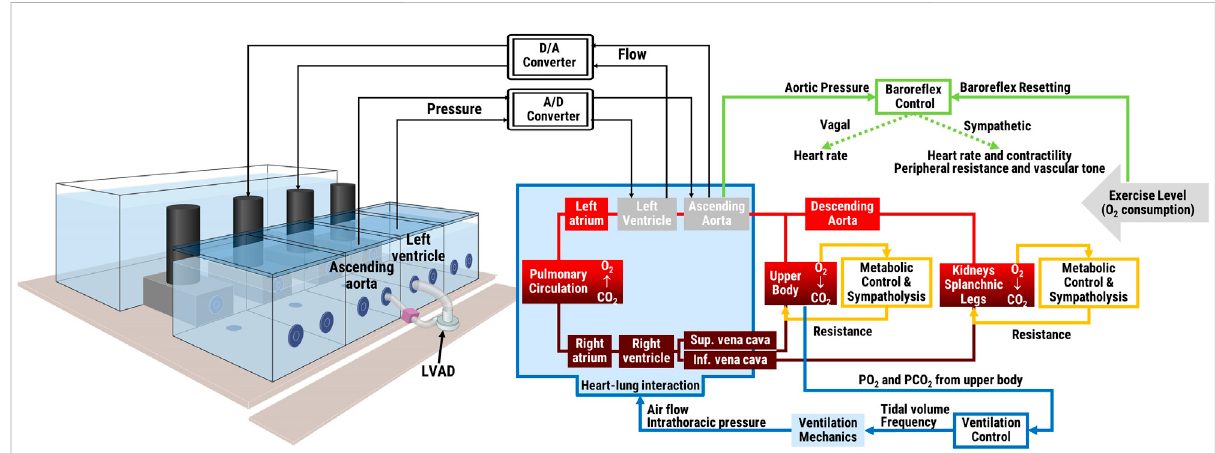
FIGURE 1 Schematic of the hybrid simulator: in vitro interface with an LVAD connected between two hydraulic chambers (left panel) and in silico lumped parameterscardiorespiratory model and its main controls (right panel). The two middle hydraulic chambers represent the leftventricle and theaorta andexchangepressureand fl owdatainreal-timewiththeremainder insilico cardiorespiratorymodel.Physicalexerciselevelisinputintothesystem as oxygen